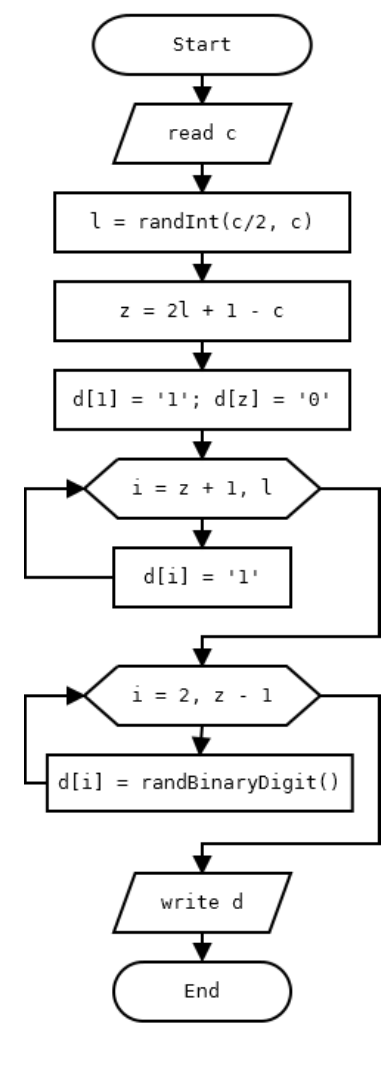
Figure 4. Algorithm of constructing the test